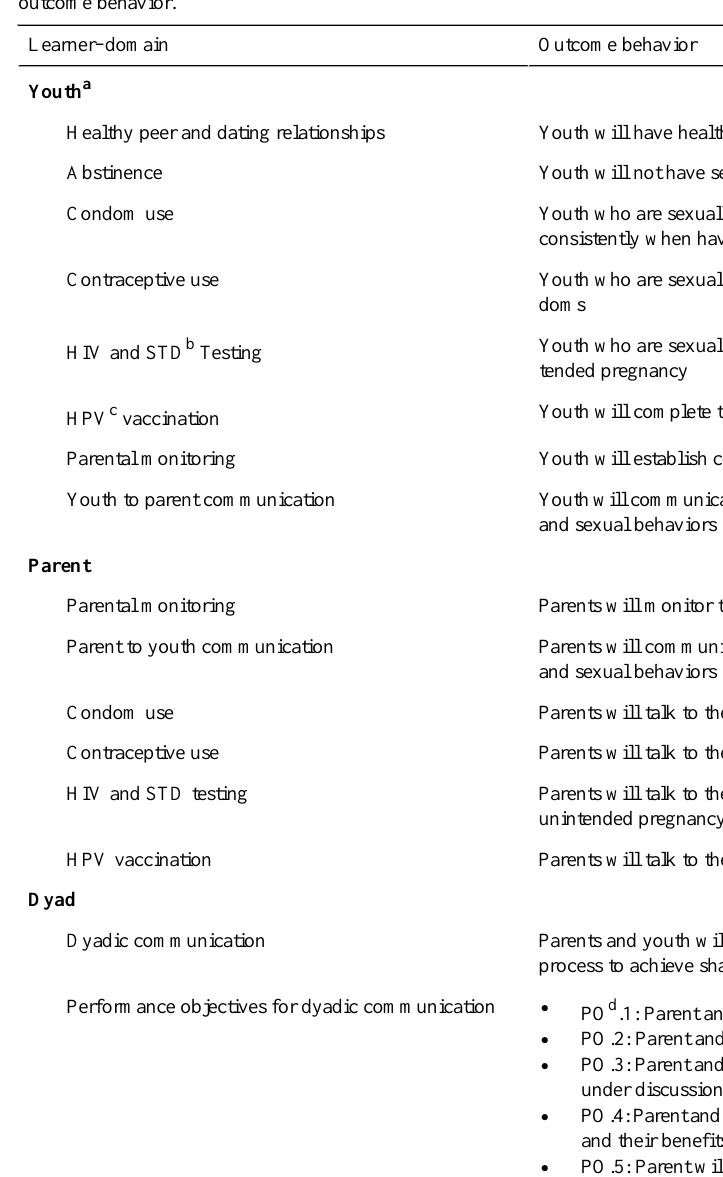
Table 2. Outcome behaviors for young adolescents, parent, and dyad with performance objectives for the dyadic (parent-young adolescent) communication outcome